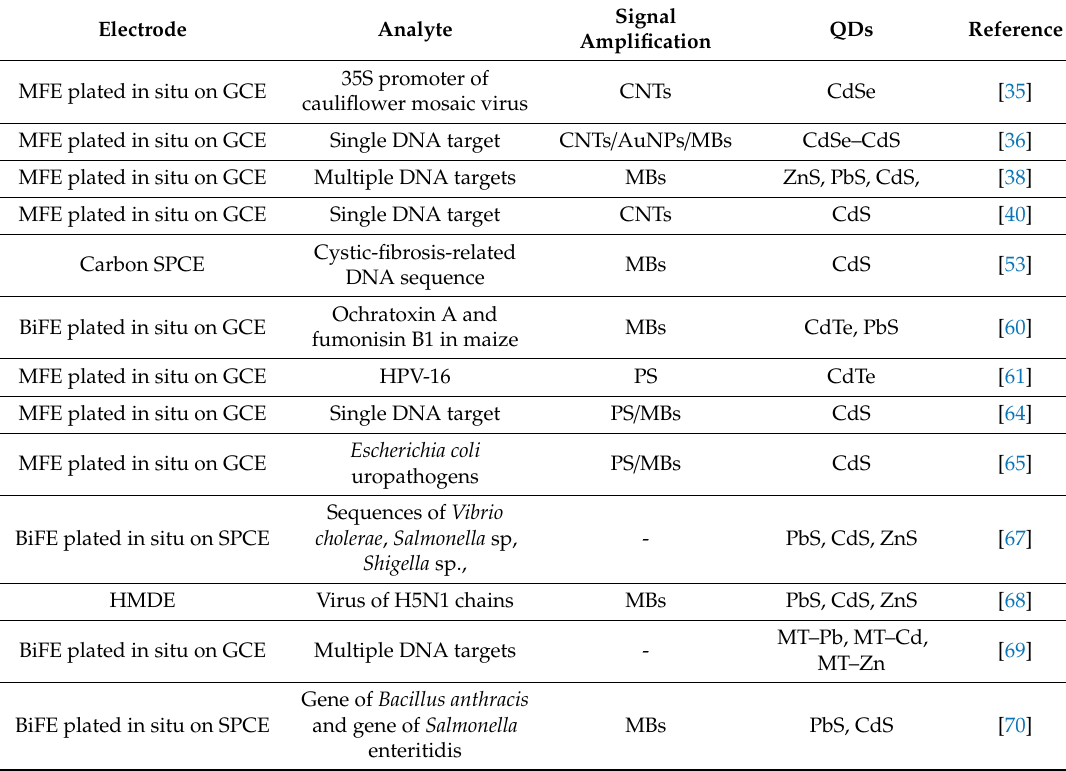
Table 1. Examples of signal amplification and multiplex strategies in DNA detection using QD labels and SV.